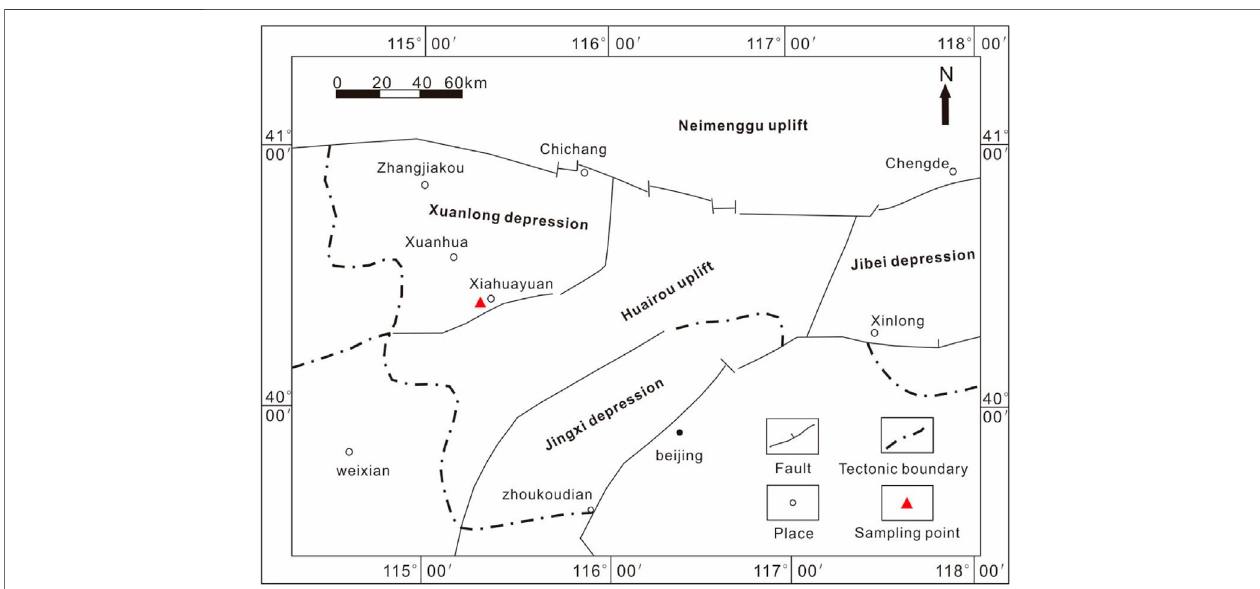
FIGURE 1 | The location at which outcrop samples were drilled from the Middle Proterozoic Xiamaling Formation (Shi et al., 2018).